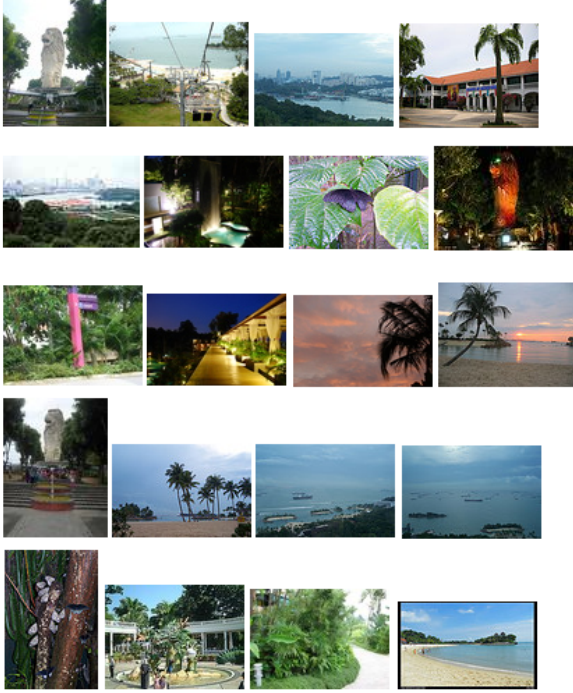
Figure 6. Sample geotagged images of Sentosa Island, Singapore on Panoramio and